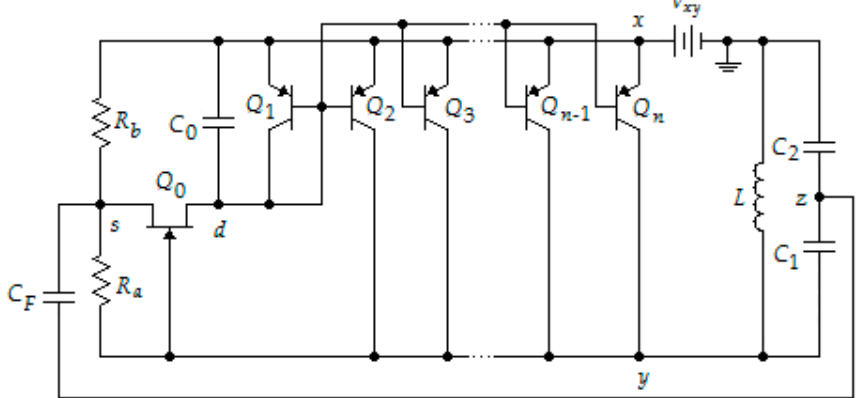
Figure 3. LC oscillator with NDR.